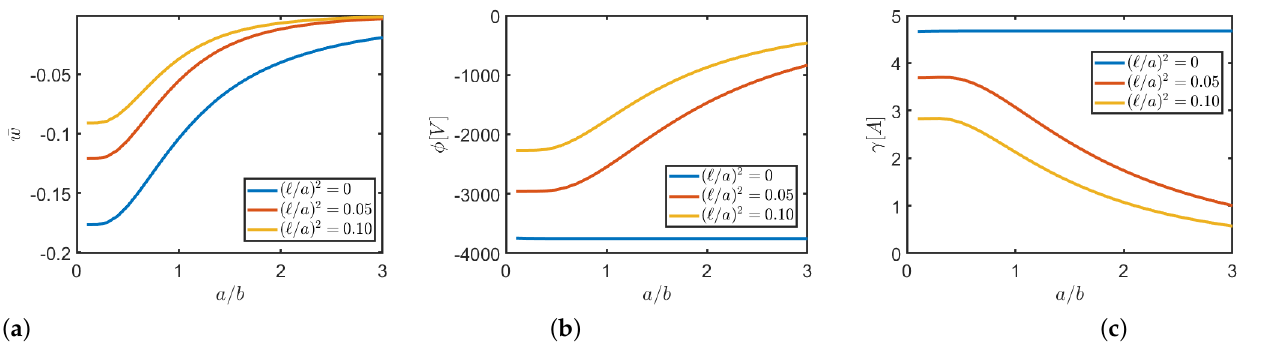
Figure 10. Graphs of displacement ¯ w ( a ) electric φ ( b ) and magnetic γ ( c ) potential, in the point ( a /2, b /2 ) to vary of a / b ratio and for different values of nonlocal parameter ( (cid:96) / a ) 2 and for n p = 1. (UDL; q = 0 N/m 2 , T 0 = T 1 = 0 K, ρ E = 0.1 C/m 2 , ρ H = 0 Wb/m 2 ).